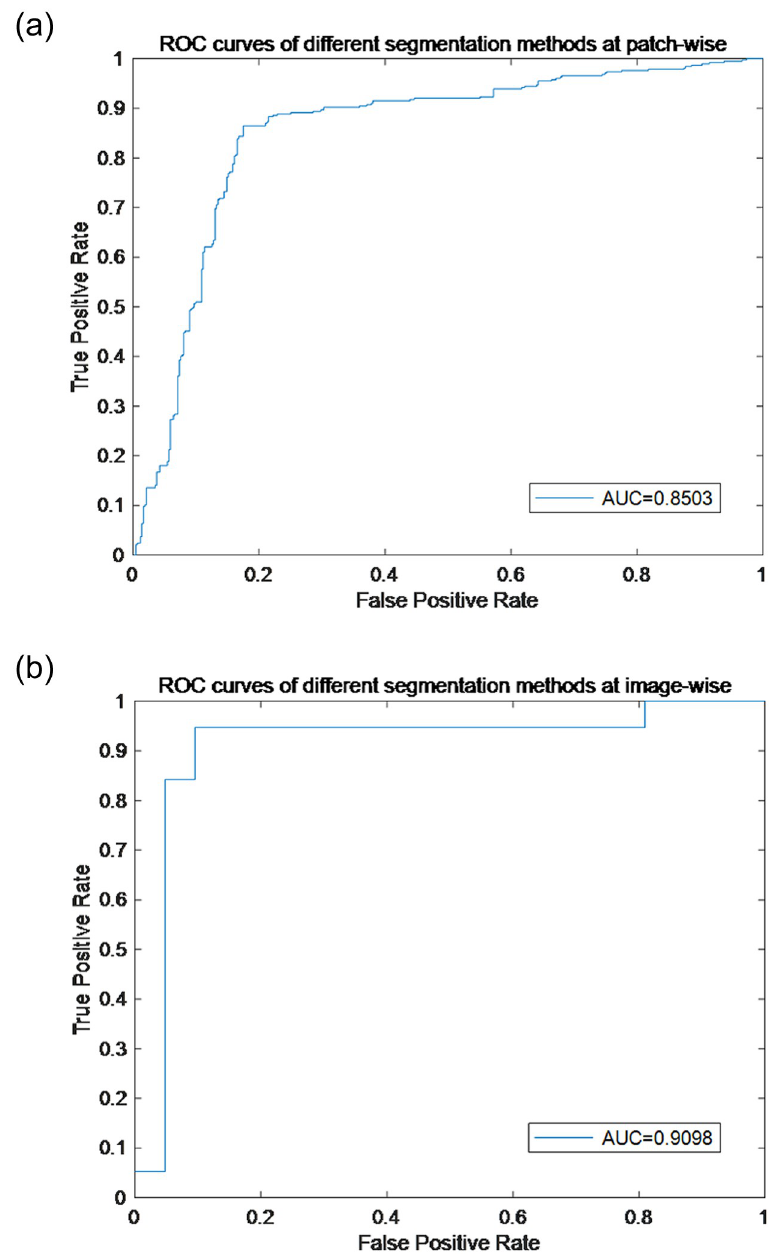
Fig 11. ROC curves of ICIAR 2018 challenge dataset. (a) ROC curves of the result at patch-wise, (b) ROC curves of the result at patch-wise.